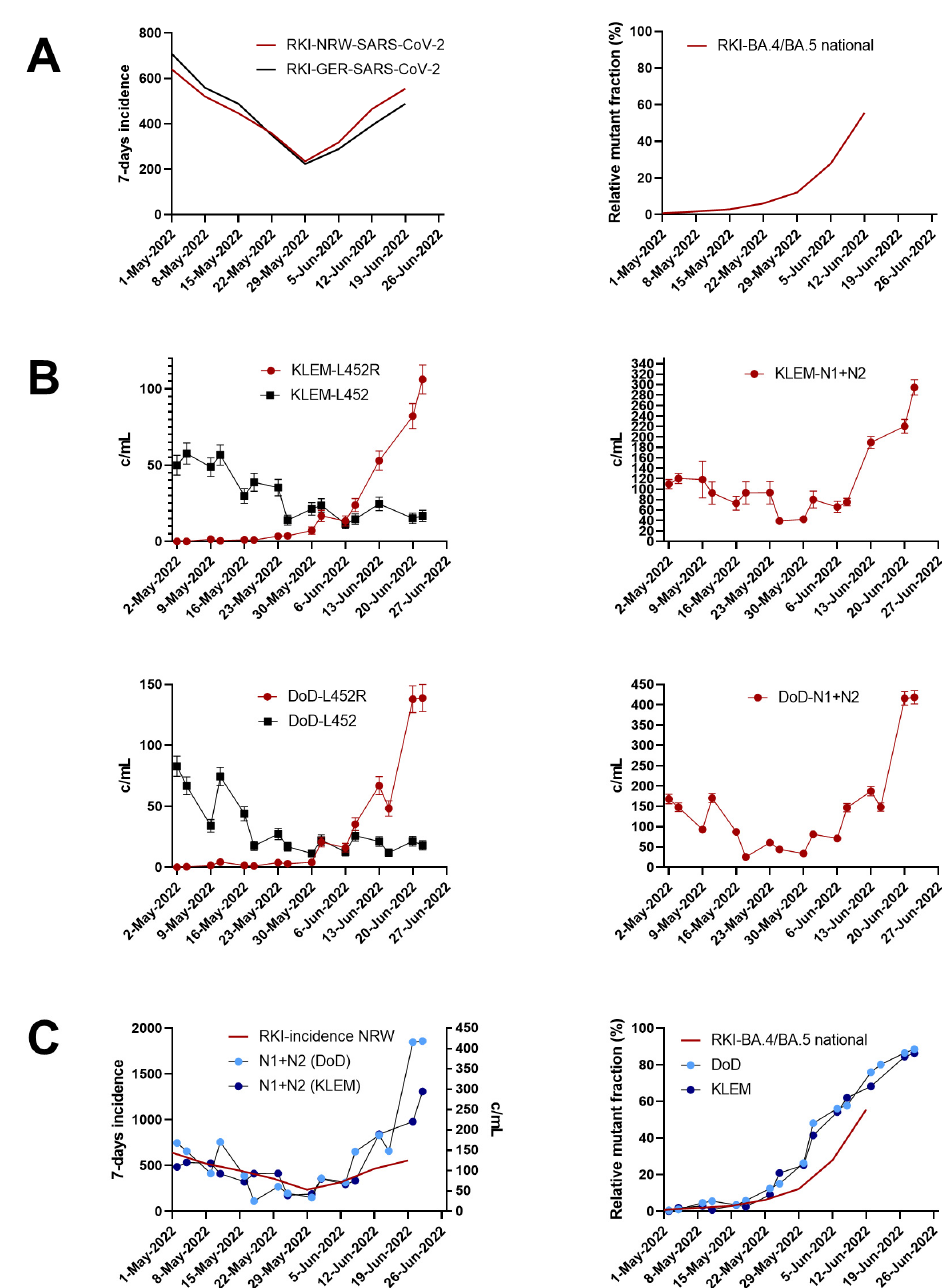
Figure 4. Tracking of SARS-CoV-2 BA.4/BA.5 specific mutant fraction of L452R using digital PCR. ( A ) Seven-day incidence (left panel) and the SARS-CoV-2 Omicron BA.4/BA.5 mutant fraction (right panel) for NRW and Germany are indicated as available during the study period. Epidemiological data are based on individual testing and were obtained from official data repository of the German federal Robert Koch Institute (RKI). ( B ) SARS-CoV-2 Omicron BA.4/BA.5 and non-BA.4/BA.5 detection targeting the substitution L452R (left panel) for WWTPs DoD and KLEM. Total SARS-CoV-2 levels in WWTPs DoD and KLEM were quantified using a SARS-CoV-2-specific N1/N2 assay (right panel) ( C ) Overlay of the 7-day incidence in NRW compared to detected SARS-CoV-2 levels in wastewater of WWTPs DoD and KLEM (left panel). Overlay of the relative mutant fraction of SARS-CoV-2 Omicron BA.4/BA.5 as provided by RKI compared to the relative fraction of L452R determined in wastewater using RT-dPCR